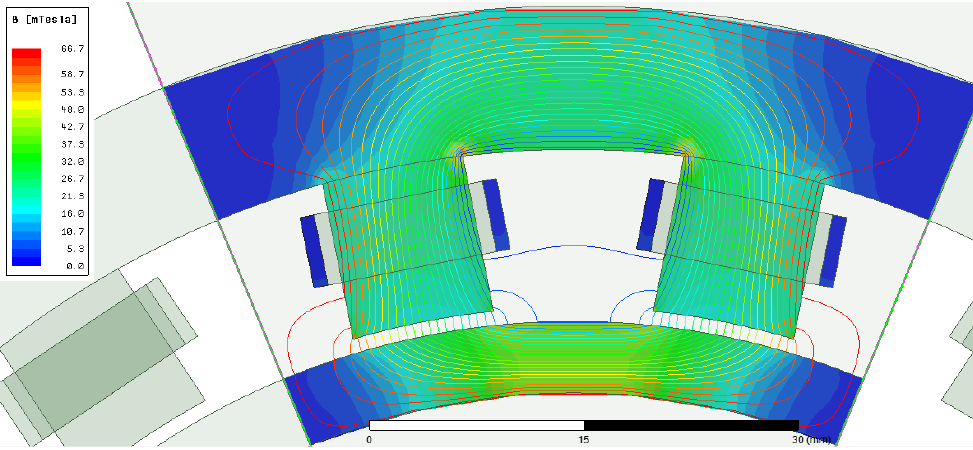
Figure 4. FEM analysis of the